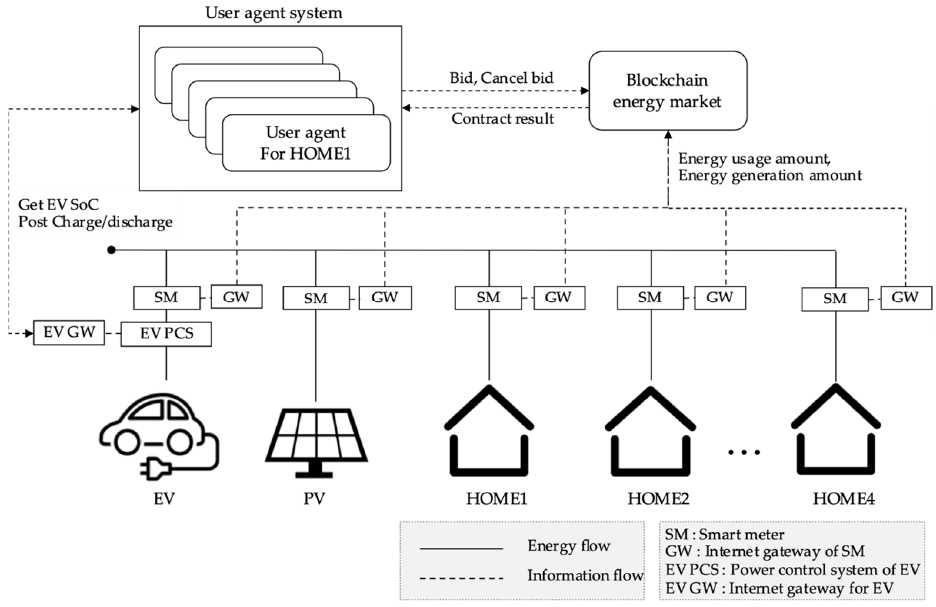
Figure 1. Diagram of the demonstration